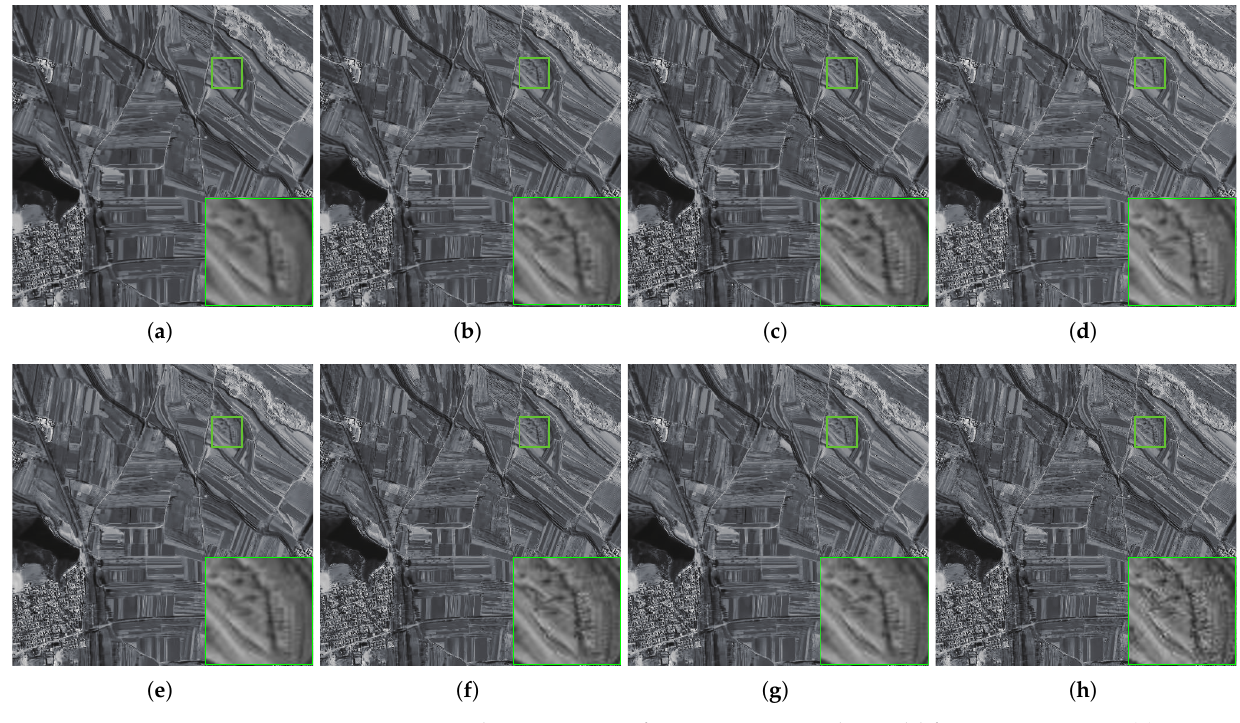
Figure 11. Visual comparison of experiments on the real-life Factory image. ( a ) NCSR [43]. ( b ) WSSR [6]. ( c ) DnCNN [18]. ( d ) DKSVD [68]. ( e ) DCDicL [73]. ( f ) LRR-CNN [74]. ( g ) DLRP [75]. ( h )